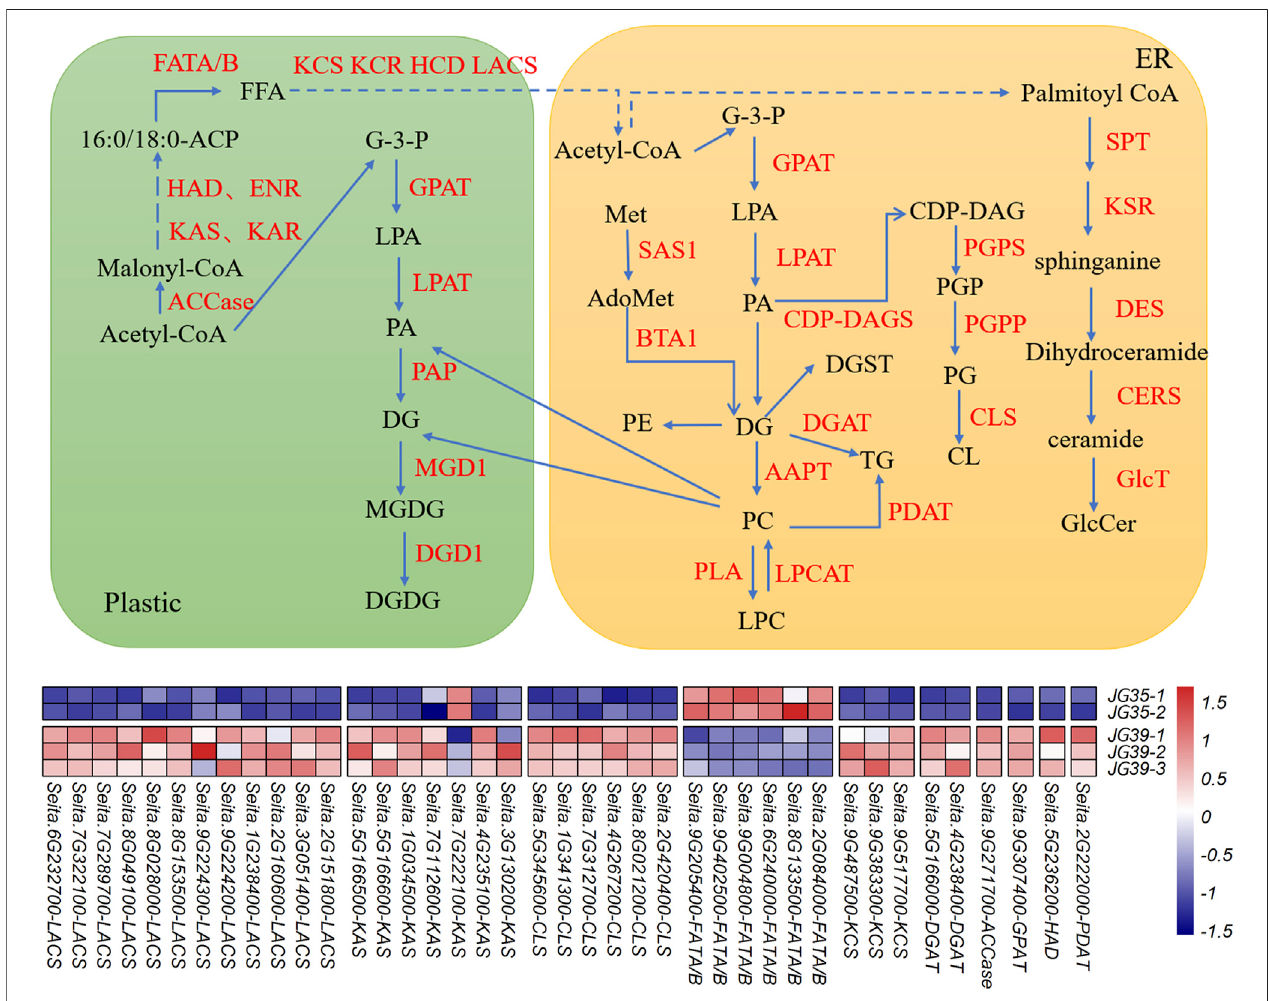
FIGURE 7 | Lipid metabolism pathway map of foxtail millet. Note: AAPT, aminoalcoholphosphotransferase; ACCase, acetyl-CoA carboxylase; Acetyl CoA, acetyl- coenzyme A; AdoMet, S-adenosylmethionine; BTA1, betaine lipid synthase; CDP-DAG, CDP-dia-cylglycerol; CDP-DAGS, CDP-DAG synthase; CERS, ceramide synthase; CL, cardiolipin; CLS, cardiolipin synthase; DES, dihydroceramide desaturase; DGD1, digalactosyldiacylglycerol synthase 1; DGAT, diacylglycerol acyltransferase; ECR, trans-2,3-enoyl-CoA reductase; ENR, enoyl-ACP-reductase; FATA/B, acyl-ACP thioesterase A/B; FFA, free fatty acids; GlcT: glycosyltransfferases; G-3-P, glycerol-3-phosphate; GPAT, glycerol-3-phosphate acyltransferase; HAD, hydroxyacyl-ACP dehydratase; HCD, 3-hydroxacyl-CoA dehydratase; KAR, β -ketoacyl-ACP reductase; KAS, ketoacyl-ACP synthase; KCR, 3-ketoacyl-CoA reductase; KCS, 3-ketoacyl-CoA synthase; KSR, 3- ketosphinganine reductase; LACS, long-chain acyl-CoA synthetase; LPAT, lysophosphatidic acid acyltransferase; LPCAT, lysophosphatidyl choline acyltransferase; MeT, methionine; MGD1, monogalactosyldiacylglycerol synthase 1; PAP, phosphatidic acid phosphatase; PLA, phospholipase A; PDAT, phospholipid:diacylglycerol acyltransferase; PG, phosphatidylglycerol; PGP, phosphatidylglycerol phosphate; PGPP, PGP phosphatase; PGPS, phosphatidylglycerophosphate synthase; SAS1, S-adenosylmethionine synthetase; SPT, serine